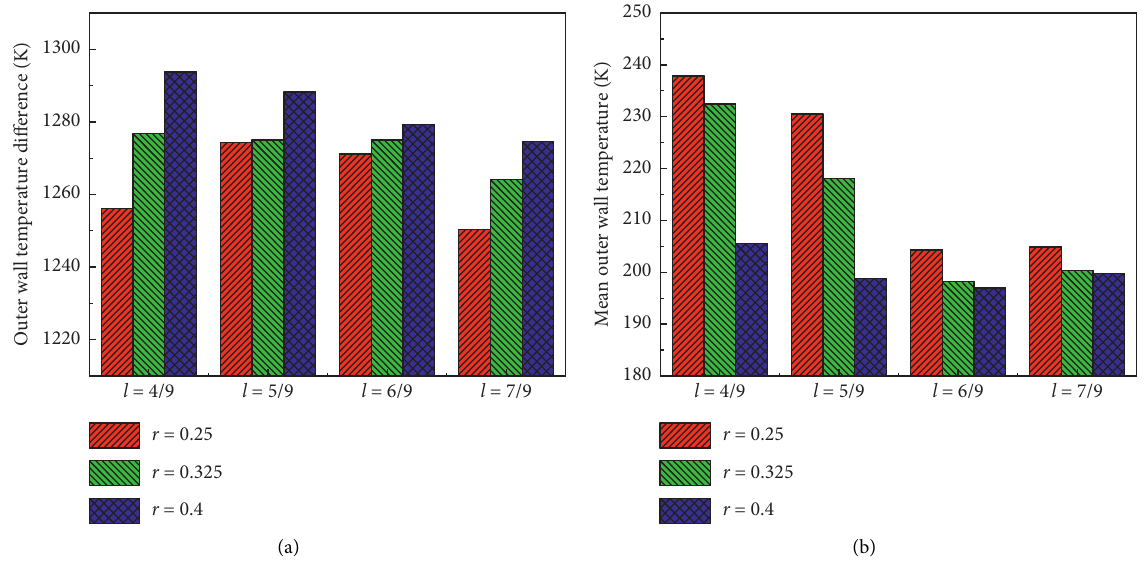
Figure 10: Mean outer wall temperature and outer wall temperature at different l and r .